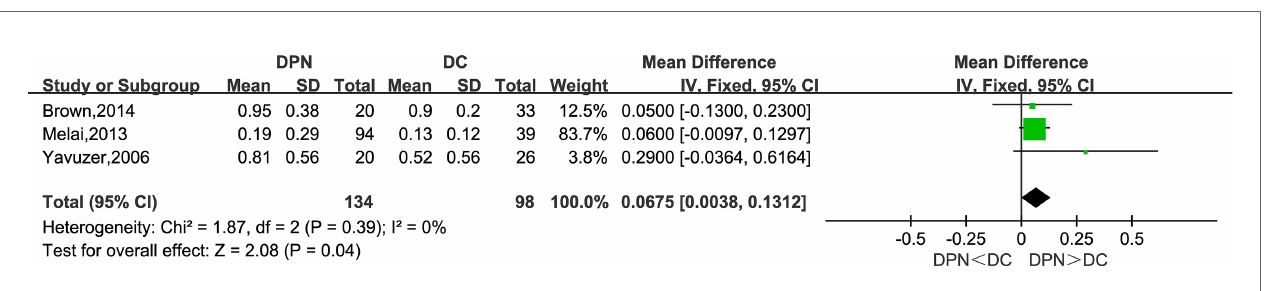
FIGURE 9 | Forest plot of maximum knee extension